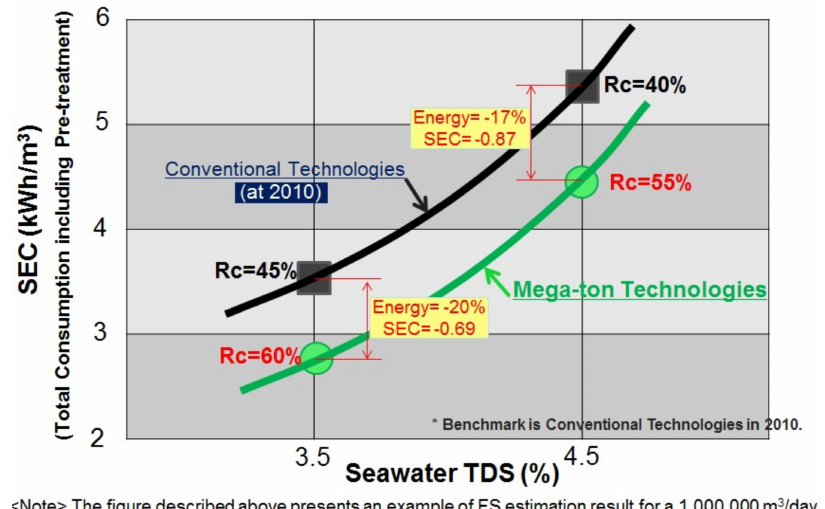
Figure 16. The relationship between specific energy consumption (kwh/m 3 ) and seawater TDS (%) [28–30]. 20% energy reduction will be expected in the case of “Mega-ton Water System” tech- nology for 3.5% TDS and 17% for 4.5% TDS